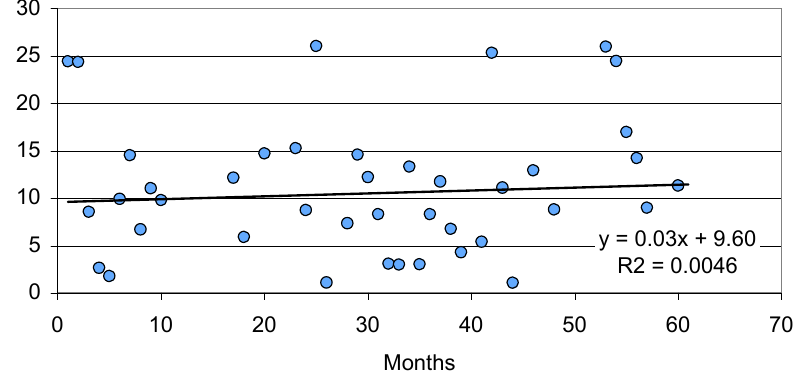
Figure 11. Startup rate coefficients for the Shannon Wetland. Operations began in June 2003.